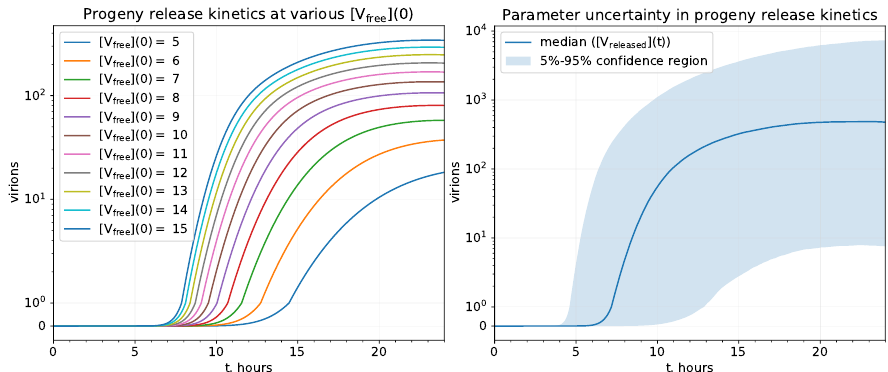
Figure 4. Uncertainty in the model output (progeny release kinetics). ( Left ) uncertainty associated with variation of the initial condition [ V free ]( 0 ) . ( Right ) uncertainty associated with variation of model parameters in the ranges specified in Table 2.